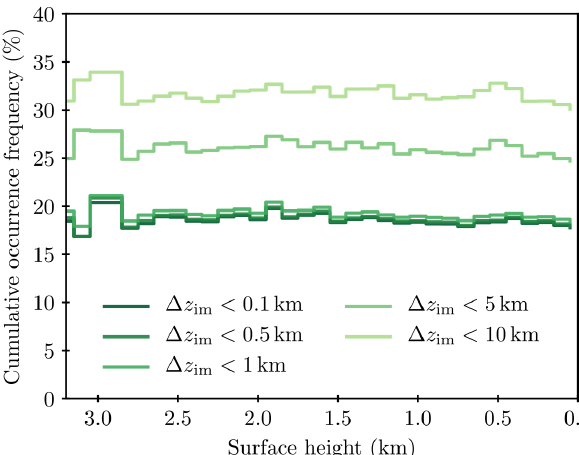
Figure B1. Distribution of (cid:49)z im with underlying surface topography.